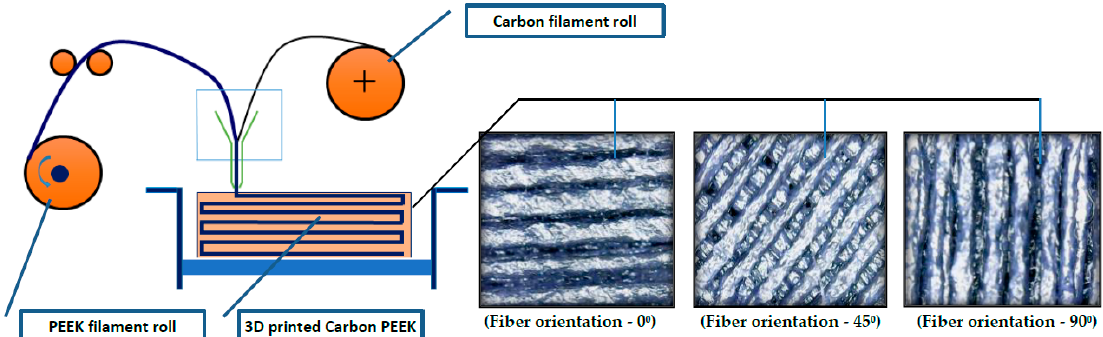
Figure 2. 3D printing process with fiber orientations.